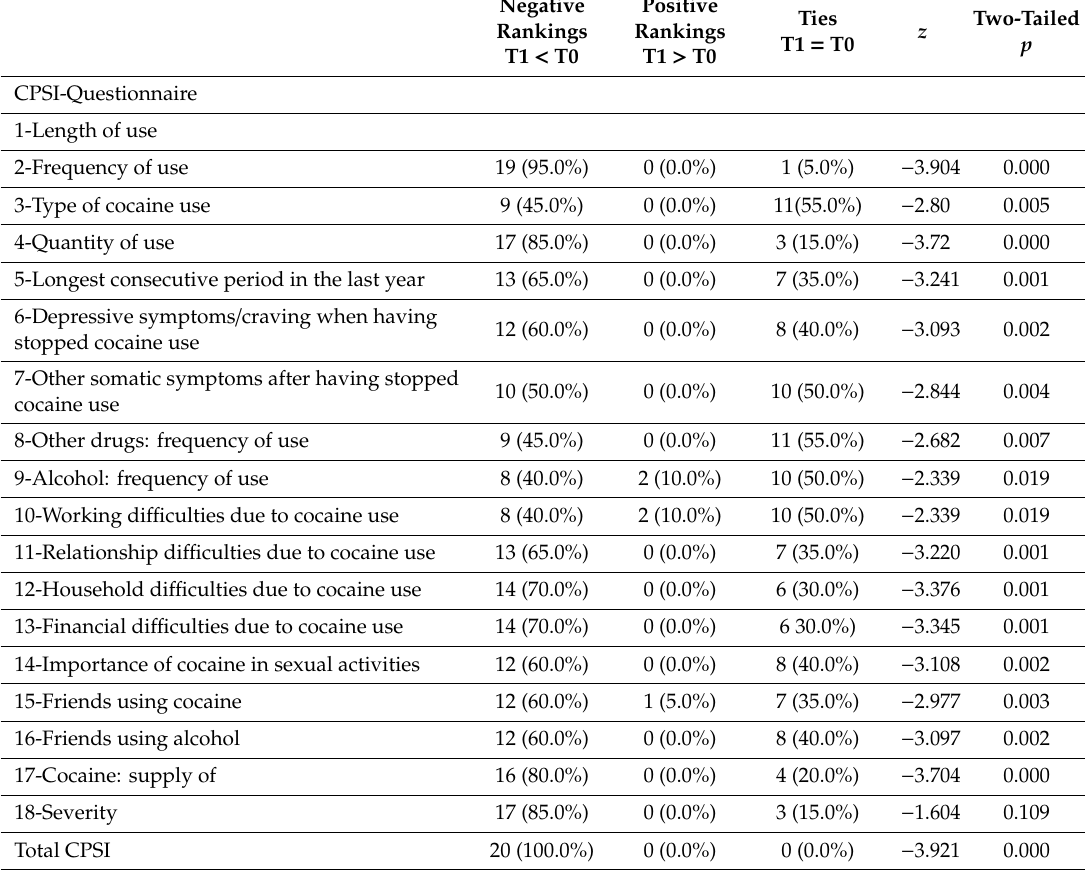
Table 2. Changes in the CPSI questionnaire and CGI severity index related to ADHD and CUD (Wilcoxon signed-rank